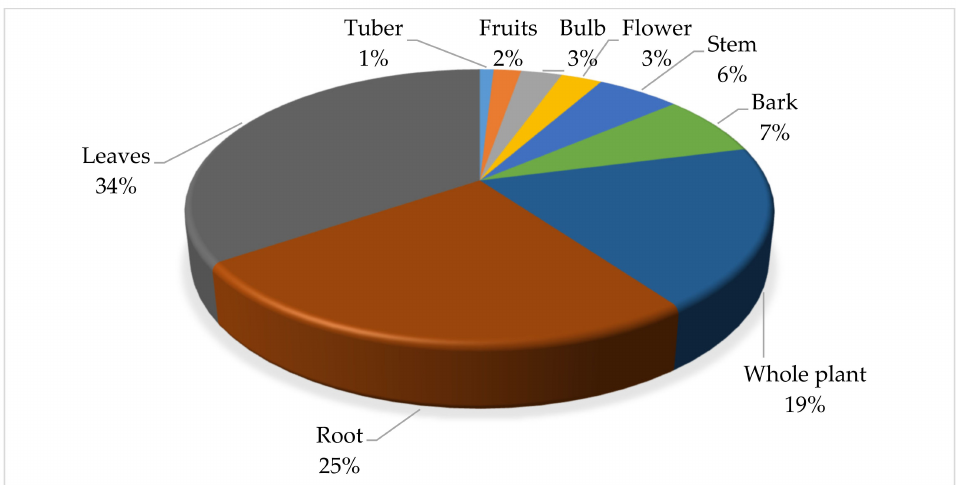
Figure 2. Distribution (%) of plant parts value used in the treatment of cattle diseases in Ramotshere Moiloa local municipality, North West Province, South Africa. ( n =